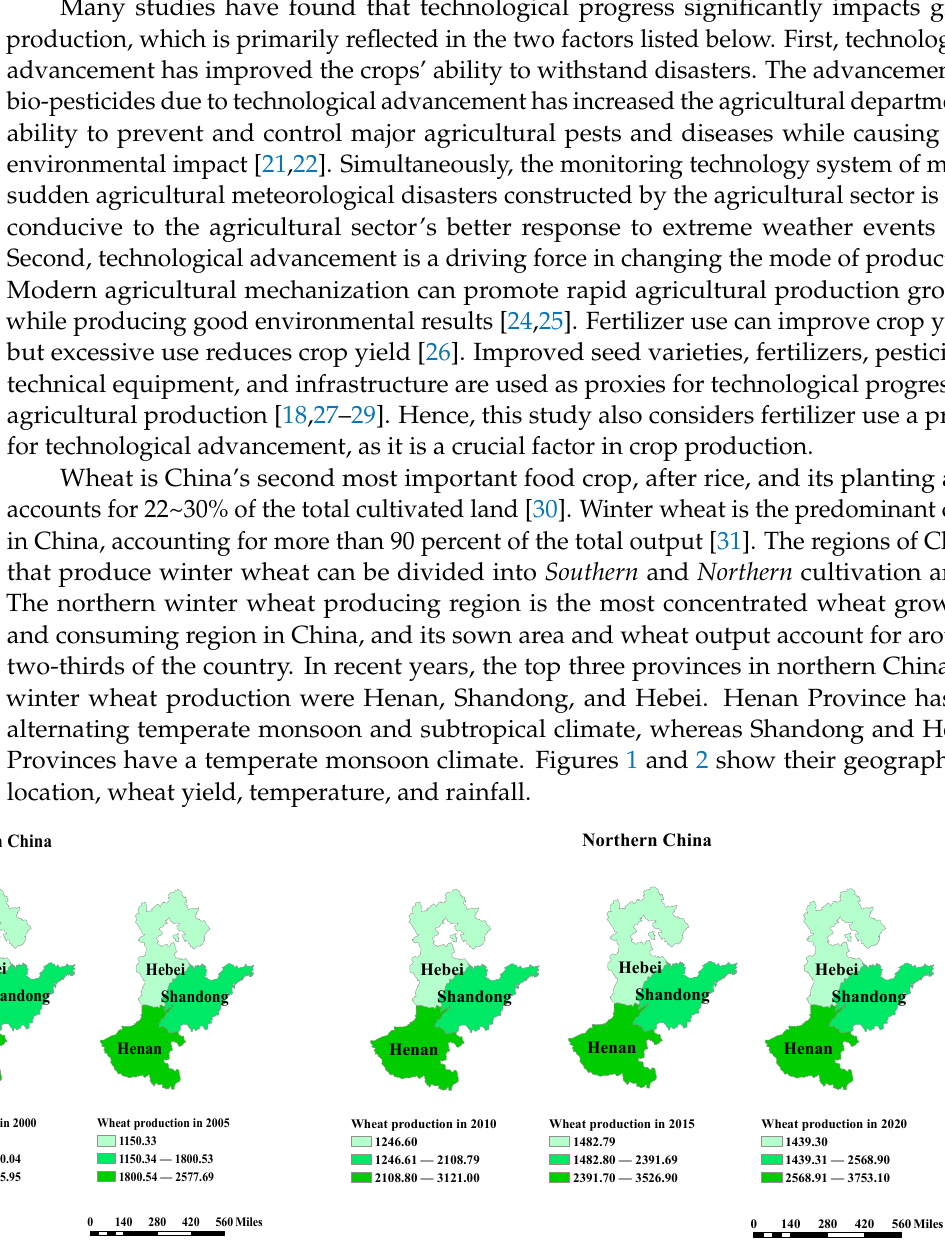
Figure 1. The distribution of wheat production (10,000 tons) in Hebei, Henan, and Shandong Provinces.